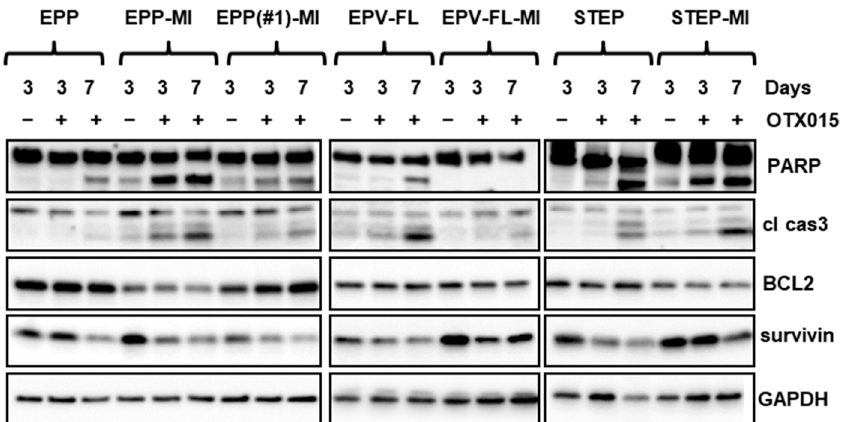
Figure 3. OTX015 triggers apoptosis in EPN cell lines. Western blot analysis of total lysates from EPN cells treated with a vehicle only ( − ) or with 500 nM OTX015 (+) for three or seven days. Blots were probed with the indicated antibodies. cl cas3 = cleaved caspase 3. Glyceraldehyde 3-phosphate dehydrogenase GAPDH was used as a loading control.